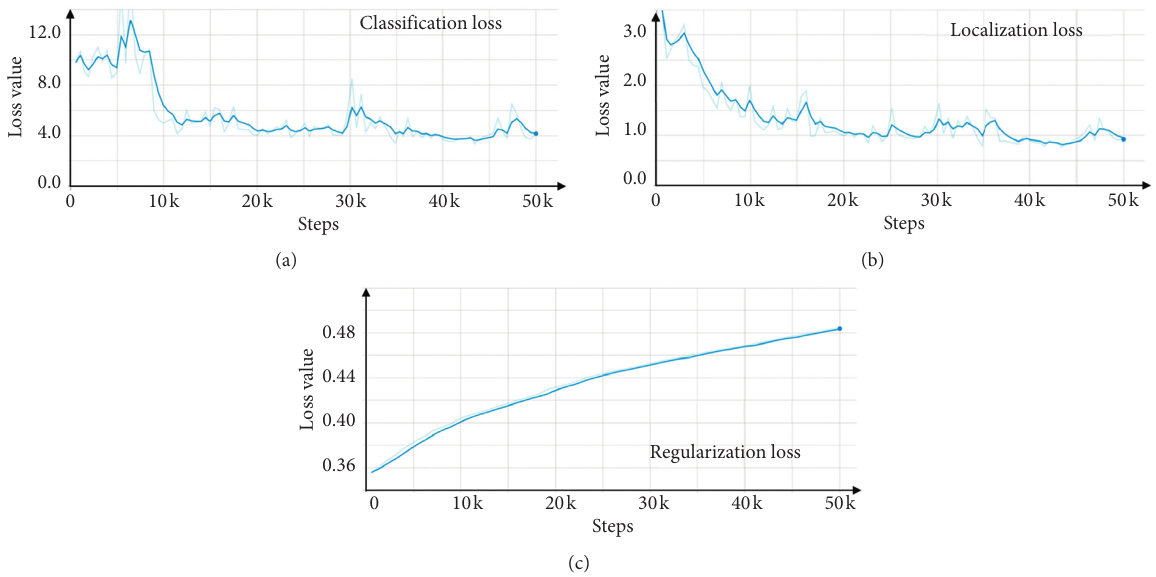
Figure 8: Partial loss function value change. (a) Classification loss. (b) Localization loss. (c) Regularization loss.